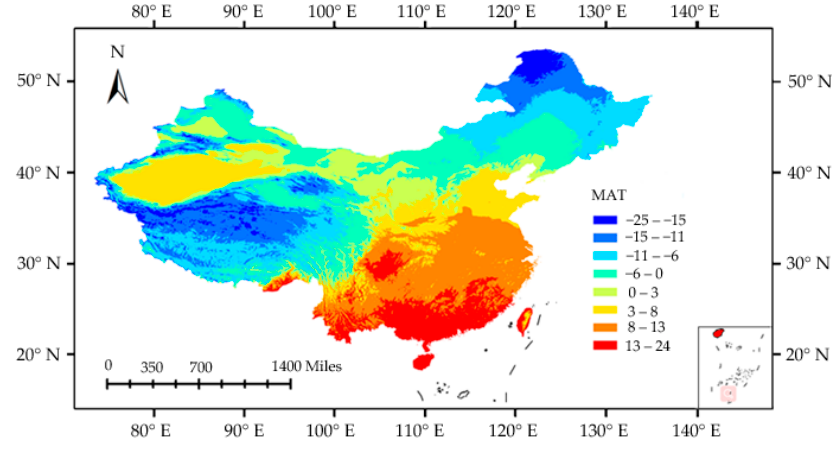
Figure 6. The LGM mean annual temperature (MAT) in China.